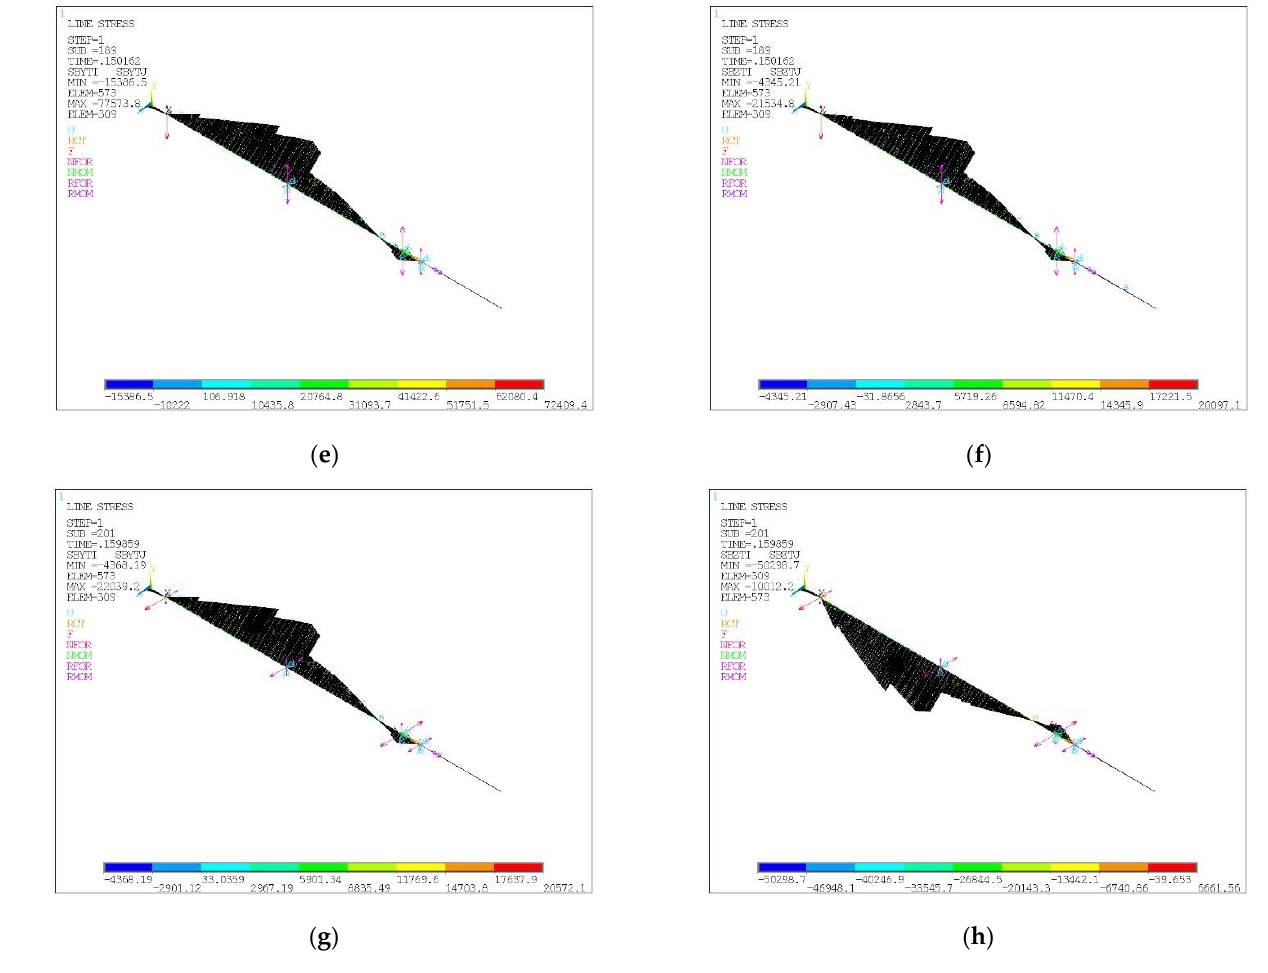
Figure 8. Plots of maximum normal stresses σ My and σ Mz (Pa), from bending moments M y and M z , respectively: ( a ) σ My at 131 ms; ( b ) σ Mz at 131 ms; ( c ) σ My at 144 ms; ( d ) σ Mz at 144 ms; ( e ) σ My at 150 ms; ( f ) σ Mz at 150 ms; ( g ) σ My at 160 ms; ( h ) σ Mz at 160 ms.